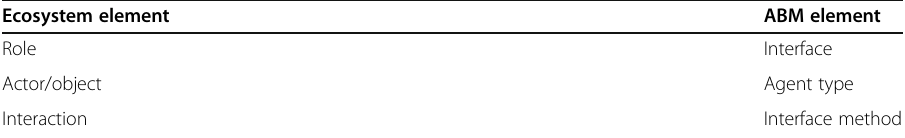
Table 3 Translation of ecosystem elements into ABM framework Ecosystem